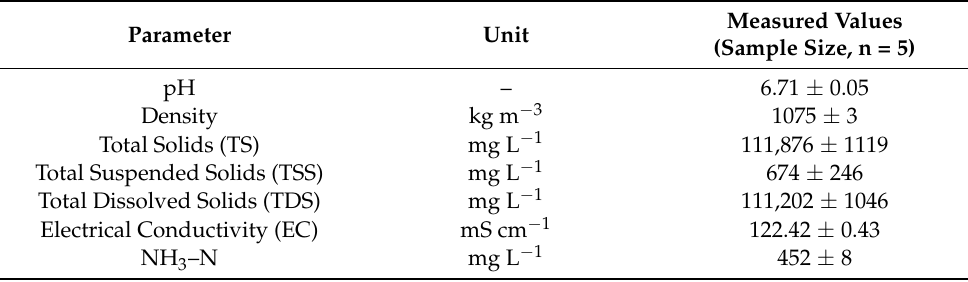
Table 1. Specific characteristics of produced water. Values represent the average ± SD of n = 5 technical